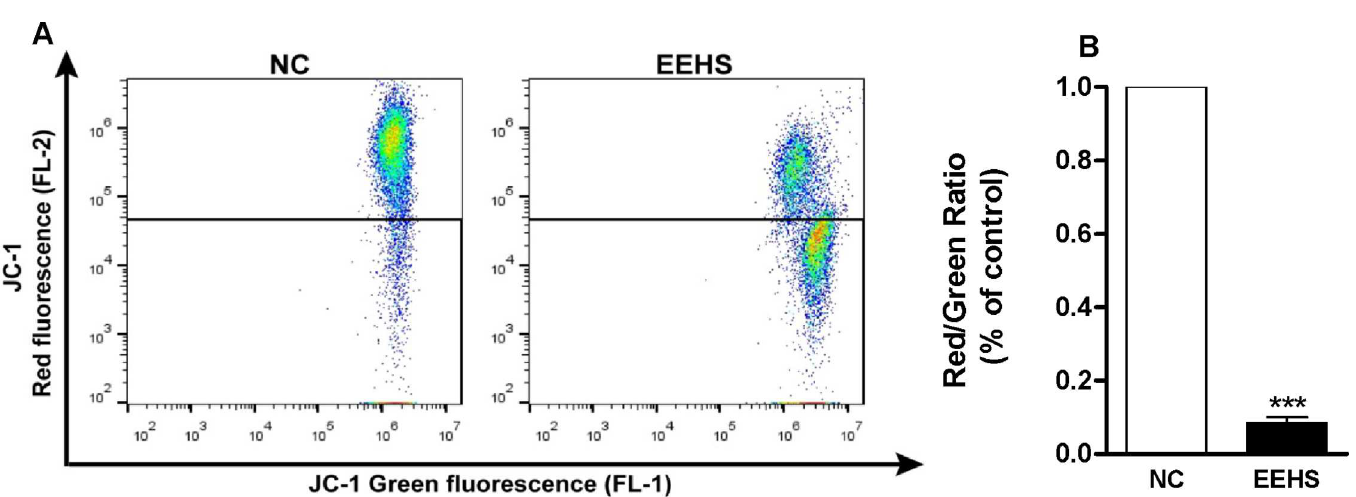
Fig 6. Estimation of the effect of the EEHS (160 μ g/mL) on the mitochondrial membranepotential of the acute myeloid leukemia cell line Kasumi-1 by flow cytometry. (A) Dot plots of flow cytometric data indicatingthe pattern of cell staining using JC-1 in green (FL-1) and red (FL-2). (B) Percentageof changeof the mitochondrial membranepotentialobtainedfrom dot plots. *** P < 0.001 when the treated groups were comparedwith the control group.